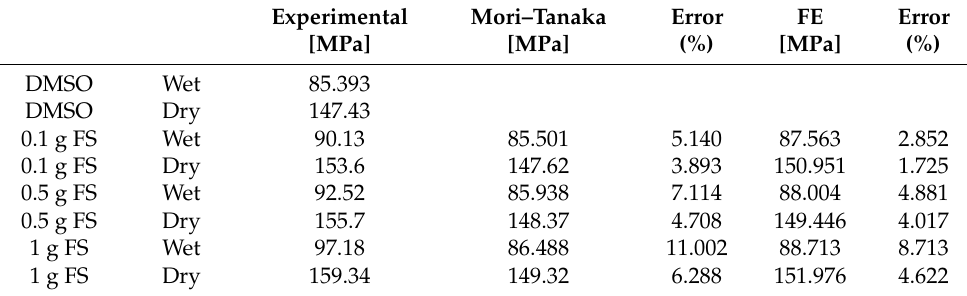
Table 4. Elasticity modulus of each membrane